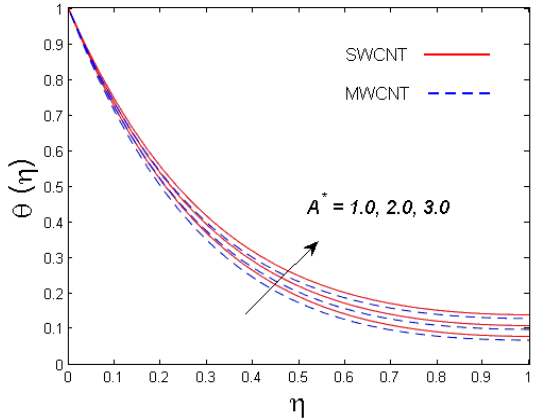
Coatings 2019 , 9 , x FOR PEER REVIEW Figure 12. The illustration of A * versus θ(η). Figure 12. The illustration of A * versus θ ( η ).